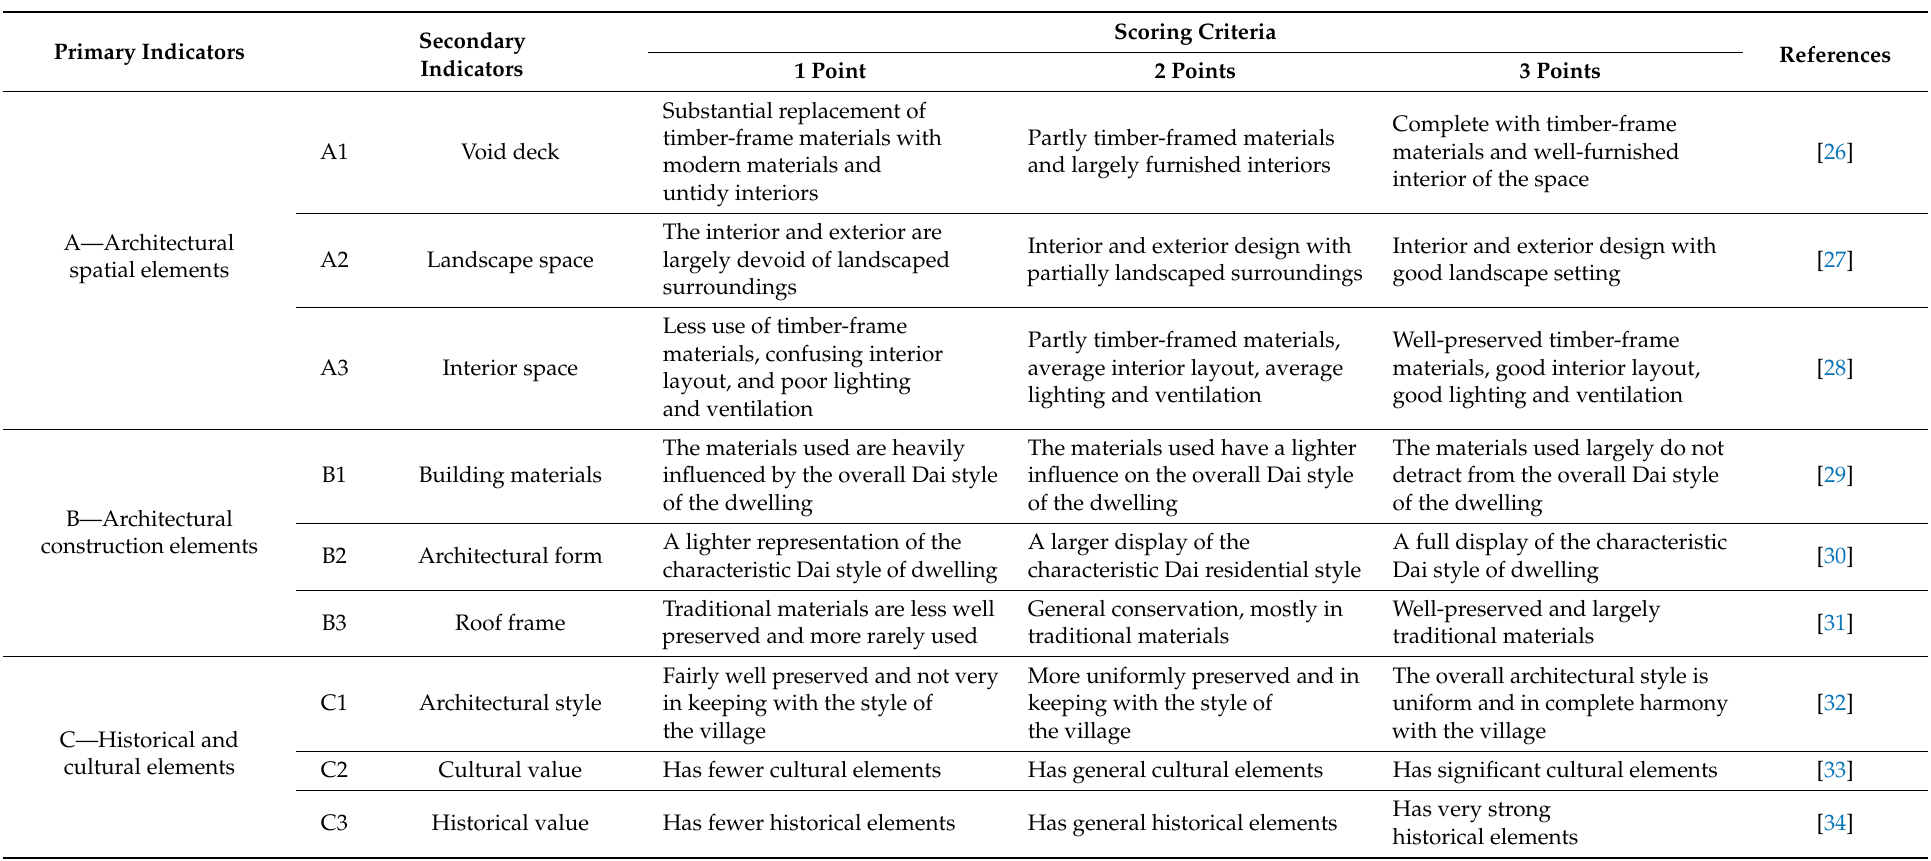
Table 1. Construction of an exterior quality assessment indicator